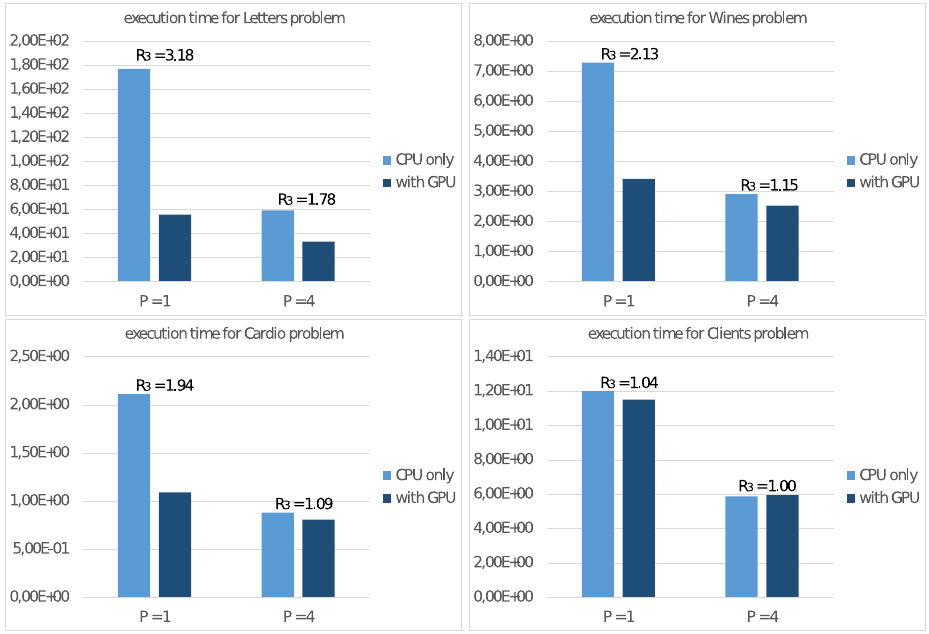
Figure 8. Execution time (in seconds) of Algorithm 2 on the NVIDIA Jetson Nano board and performance gains R 3 obtained through GPU usage.